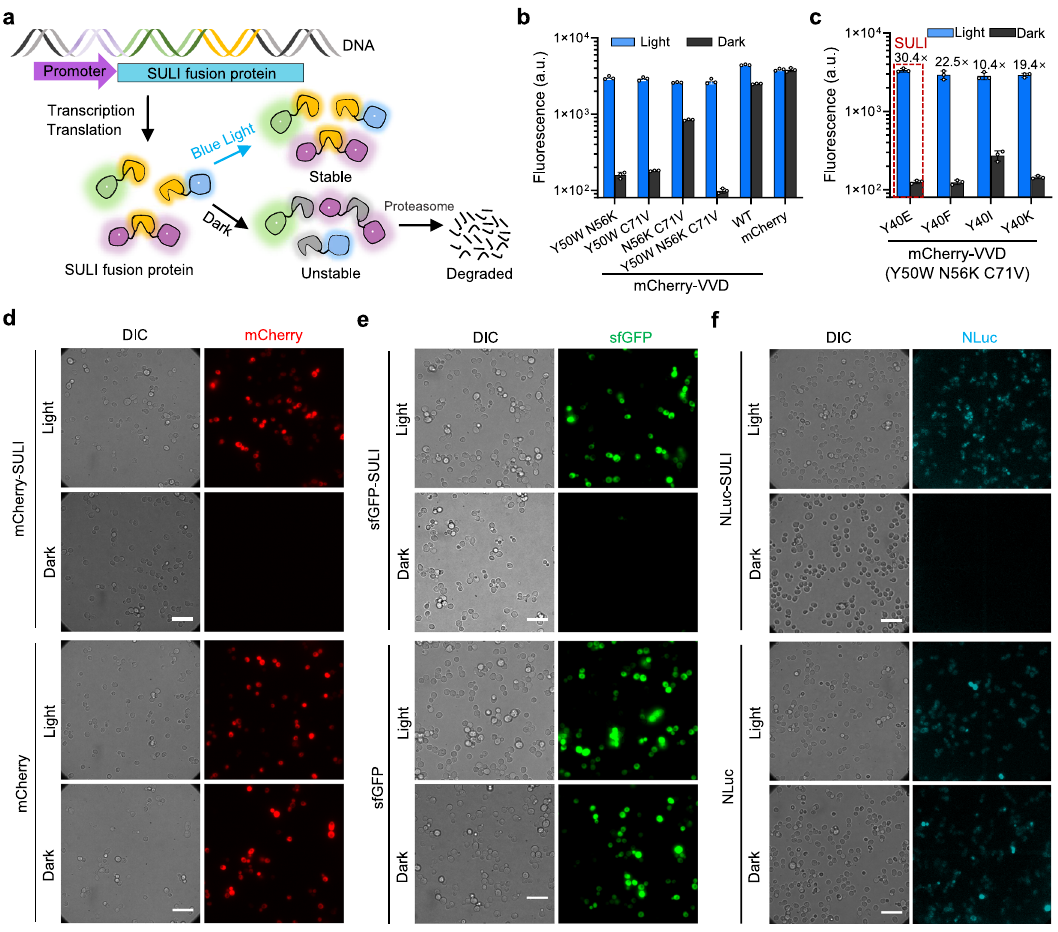
Fig. 1 | Design, optimization, and validation of a monomeric photosensitive degron. a Schematic of the SULI-mediated degradation of a protein of interest (POI) by light. The SULI fusion protein is stable upon exposure to blue light but is unstable and degraded by the proteasome under dark conditions. b Changes in stabilities between dark and light conditions for different VVD variants. Yeast cells expressing different mCherry-VVD variants were cultured under light or dark condition for 15h before mCherry fl uorescence was analyzed by fl ow cytometry. The data are presented as the mean±SD from three biological replicates. a.u., arbitrary units. c Effects of the Y40 mutation in VVD (Y50W N56K C71V) on light-